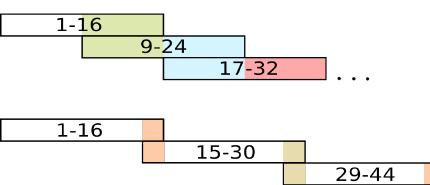
Figure 5. Example of training ( upper ) and testing data batch overlapping ( lower ) for brain dataset. Numbers show which slices of the scan each batch